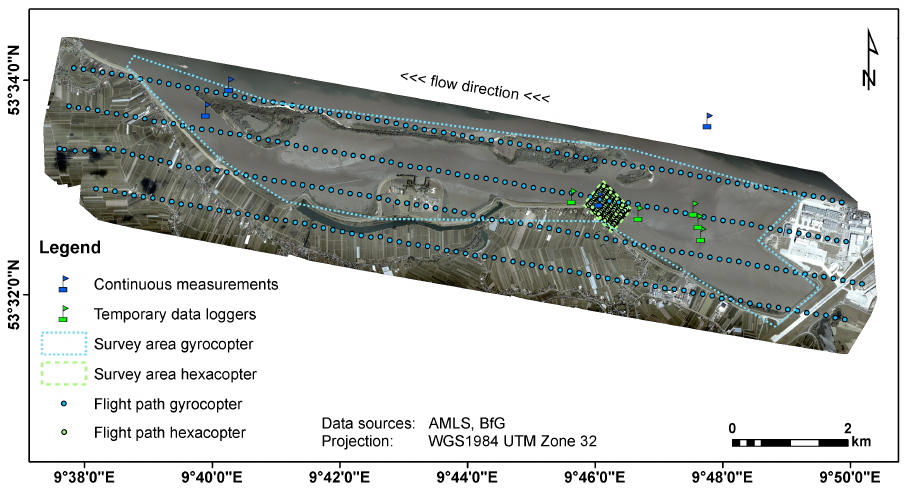
Figure 1. Survey areas of gyrocopter and hexacopter and locations of the in situ T w measurement. During the diurnal flooding of the Hahnöfer Nebenelbe, the water enters downstream of Hanskalbsand and upstream of Neßsand and the water masses meet South of Neßsand. The water also gradually overflows the tidal mudflats next to the islands and the dike. Due to the mixing point location and the potential survey of a channel and tidal mudflats simultaneously, the survey area of the hexacopter was planned for this part of the side channel (dashed green line in Figure 1). Additional considerations included a suitable landing place and a view of the flight area unobstructed by trees from the dike. For the gyrocopter, the whole Hahnöfer Nebenelbe and a part of the main Elbe channel were chosen as the survey area (dotted blue line in Figure